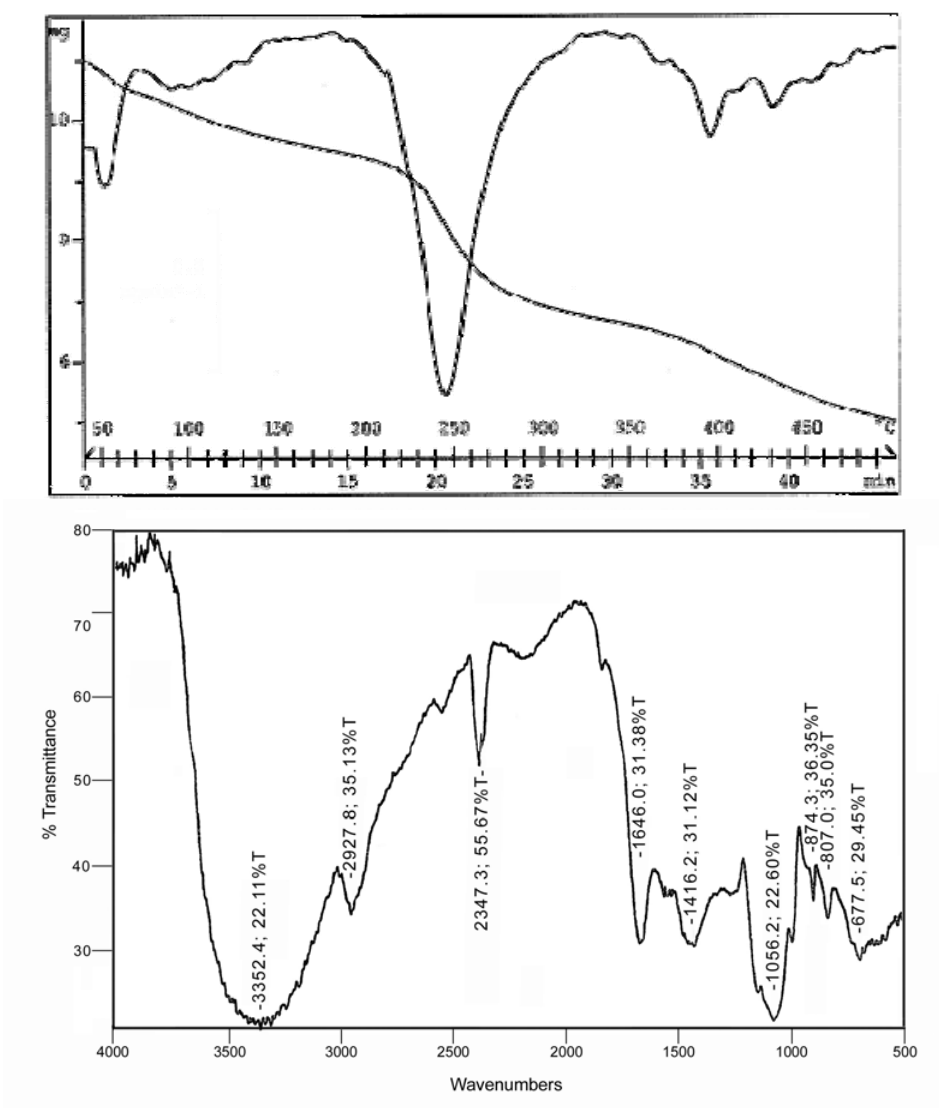
Figure 4 . Thermogravimetric analysis (top) and Fourier Transform Infrared spectrum (bottom) of Sample A